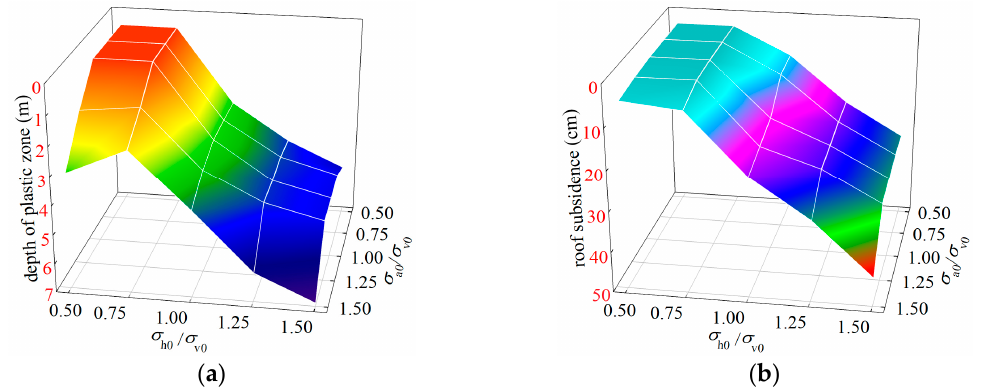
Figure 10. Results considering both strain softening and dilatancy: ( a ) roof plastic zone depth and ( b ) roof subsidence. roof